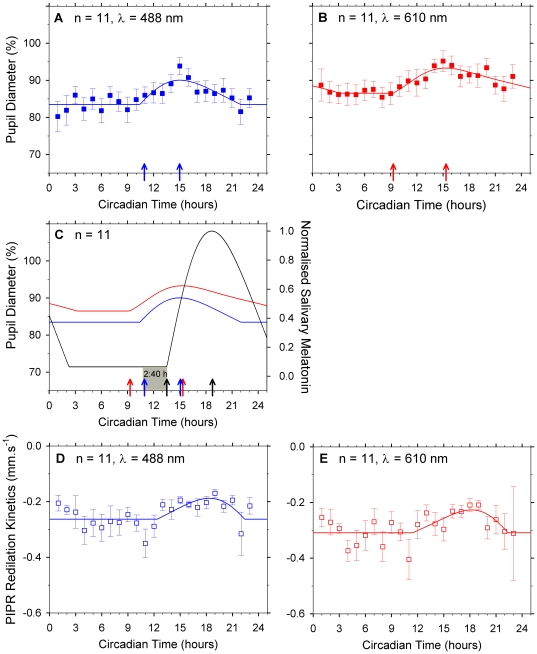
Comparison of the circadian response of intrinsic ipRGC and cone
inputs to the post-illumination pupil response (PIPR) with salivary
melatonin.Symbols (n = 11 participants; mean ± s.e.m)
and lines (mean skewed baseline cosine function; Eq 1) encode intrinsic
ipRGC (blue) and cone inputs (red) to the ipRGC controlled PIPR and
salivary melatonin (black). Arrows indicate threshold change in activity
based on the group model. (A) PIPR diameter (488 nm stimulus) began to
increase at 10:50 h and peaked at 14:58 h (blue arrows)
(R2 = 0.65). (B) PIPR diameter (688 nm
stimulus) began to increase at 9:16 h and peaked at 15:18 h (red arrows)
(R2 = 0.80). (C) Salivary melatonin
began to increase at 13:30 h and peaked at 18:40 circadian hours (red
arrows) (R2 = 0.96), 2:40 hours after
PIPR (488 nm) began to increase. For the best-fitting salivary melatonin
curve (Eq 1), (b) = 4.54 pM; peak
amplitude above baseline
(H) = 65.40 pM; width
(c) = −0.091; phase
(Φ) = 11.46 radians and
skewness (v) = 0.302. (D)
Re-dilation kinetics (mm.s−1) derived from the
time-constant of the best-fitting exponential functions to the 488 nm
PIPR. (E) Re-dilation kinetics (mm.s−1) for the 610 nm
PIPR. Change in post-illumination pupil response amplitude and kinetics
independent of the constant external illumination demonstrates circadian
control of ipRGC activity.